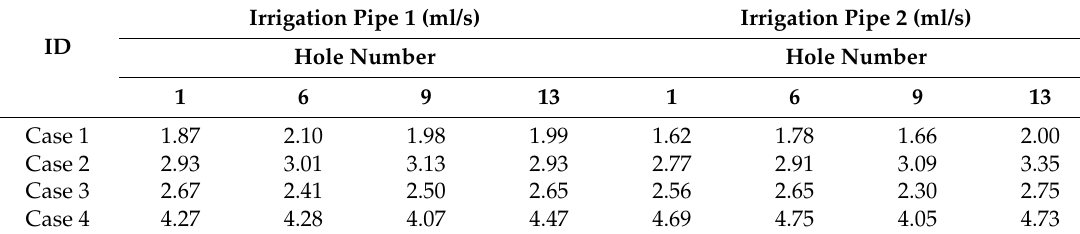
Table 9. Actual flow rate of each irrigation hole.